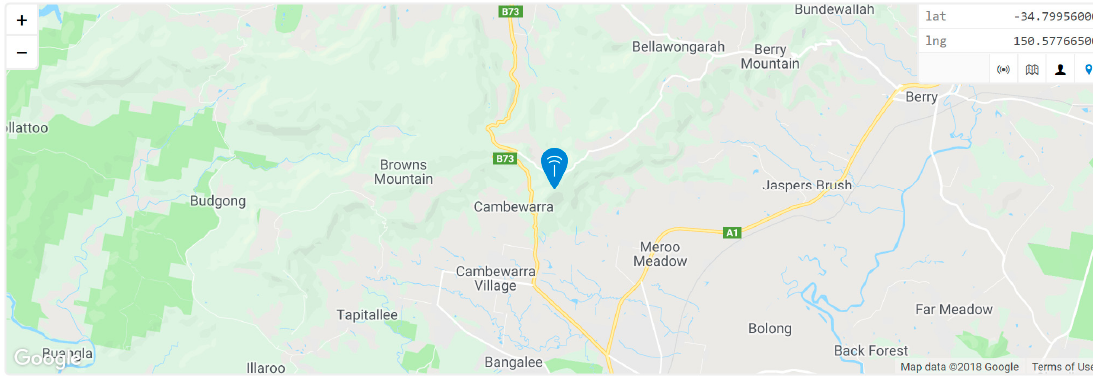
Figure 17. Cambewarra base station placement.